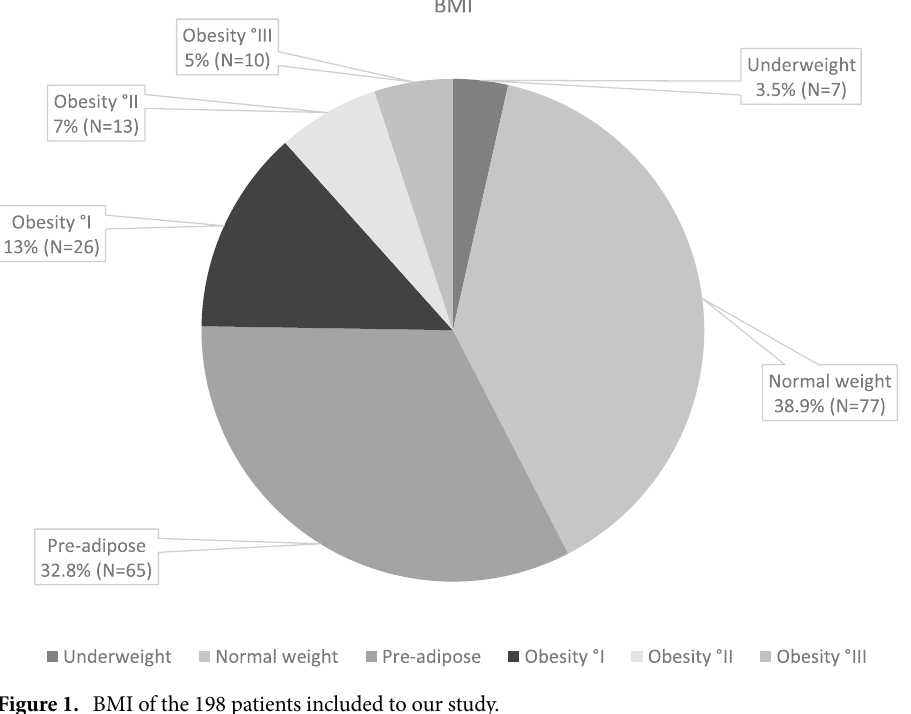
Figure 1. BMI of the 198 patients included to our